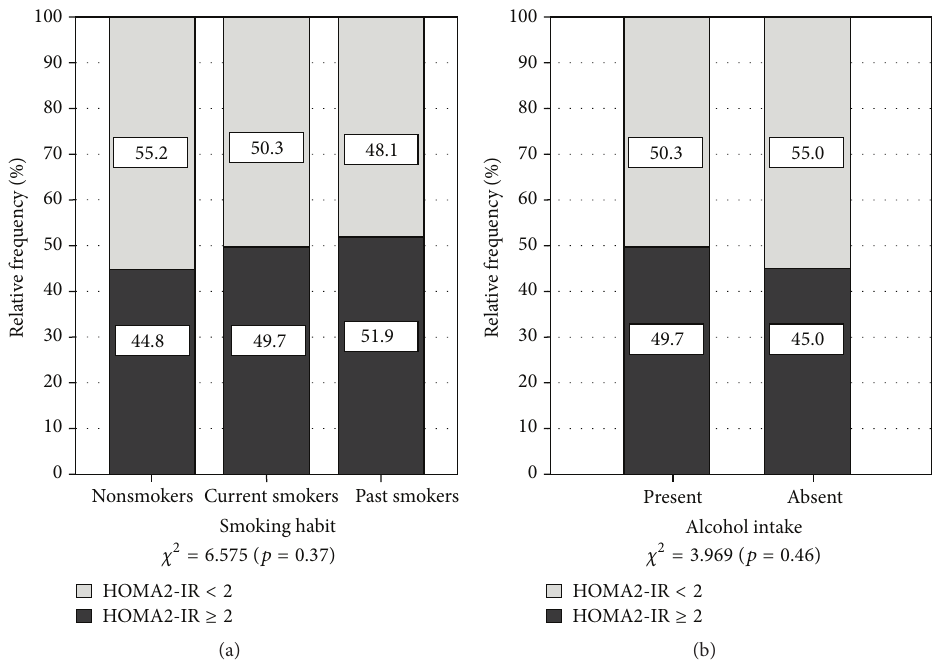
Figure 2: Prevalence of insulin resistance in the general population by smoking habits and alcohol intake. Maracaibo, Venezuela. 2014. 𝜒 2 = Pearson’s Chi-squared test. 𝑍 test for proportions: smoking habits: nonsmokers (HOMA2-IR < 2 versus HOMA2-IR ≥ 2; 𝑝 < 0.05 ); past smokers (HOMA2-IR ≥ 2 versus HOMA2-IR < 2; 𝑝 < 0.05 ). Alcohol intake: present (HOMA2-IR ≥ 2 versus HOMA2-IR < 2; 𝑝 < 0.05 ); absent (HOMA2-IR < 2 versus HOMA2-IR ≥ 2; 𝑝 < 0.05